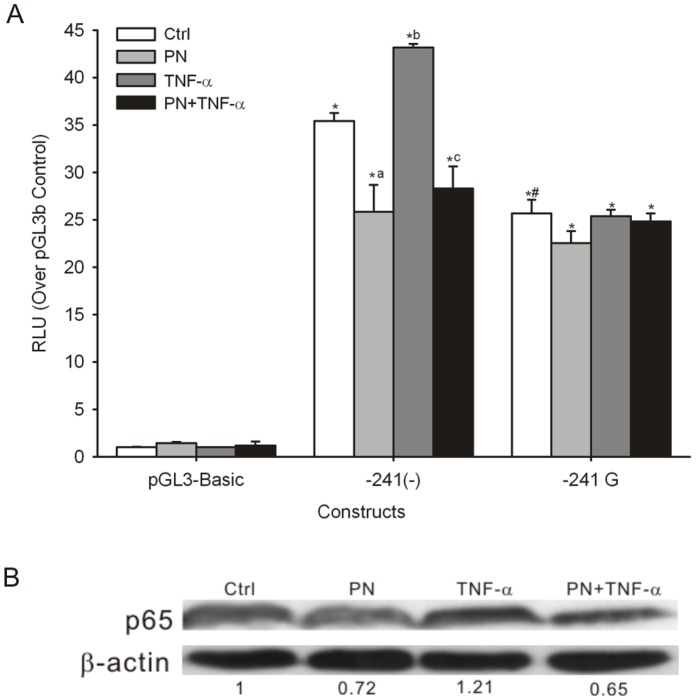
Functional analysis of the−241 (−/G) variant in the PPP2R1A proximal promoter.
A. Transcriptional activity of fragments bearing the PPP2R1A proximal promoter with variant allelotype of −241 (−) or −241 G was measured by Dual Luciferase Assays in immortalized human normal hepatocyte L02 cells. The results are expressed as fold increases in RLU over the empty pGL3-Basic vector (Ctrl). Compared with the basal activity of Ctrl, the promoter activity of the pGL3b-2R1Ap-241(−) or −241G with or without treatment was higher (∗ P<0.05). Compared with pGL3b-2R1Ap-241(−) construct, the construct with −241 G allele had lower activity (#
P<0.05). Compared with the Ctrl of pGL3b-2R1Ap-241(−), the promoter activity of constructs containing −241 (−) was significantly decreased when treated with parthenolide (PN) (a
P<0.05), and was significantly increased after TNF-α induction (b
P<0.05). Compared with the TNF-α treatment alone, the promoter activity was decreased after treatment with PN+TNF-α in constructs carrying the −241 (−) allele (c
P<0.05). However, there was not changed of the promoter activity in the constructs with the −241 G allele among the Ctrl and the different treatment groups (P>0.05). B. Immunoblot characterization of the nuclear NF-κB p65 translocation after treatment with NF-κB activator or inhibitor in L02 cells. The expression of p65 was inhibited 28% after treatment with PN, while the expression of p65 was significantly increased by 21% after treatment with TNF-α. When pretreated with PN for 4 h and stimulated with TNF- for another 24 h (PN+TNF-α), the expression of p65 was still decreased by 35% in L02 cells (P<0.05). The numbers under the graph represent the fold of relative expression level of nuclear NF-κB p65 (Ctrl group level set as 1.0). The results represent the mean ± SD of three independent experiments.